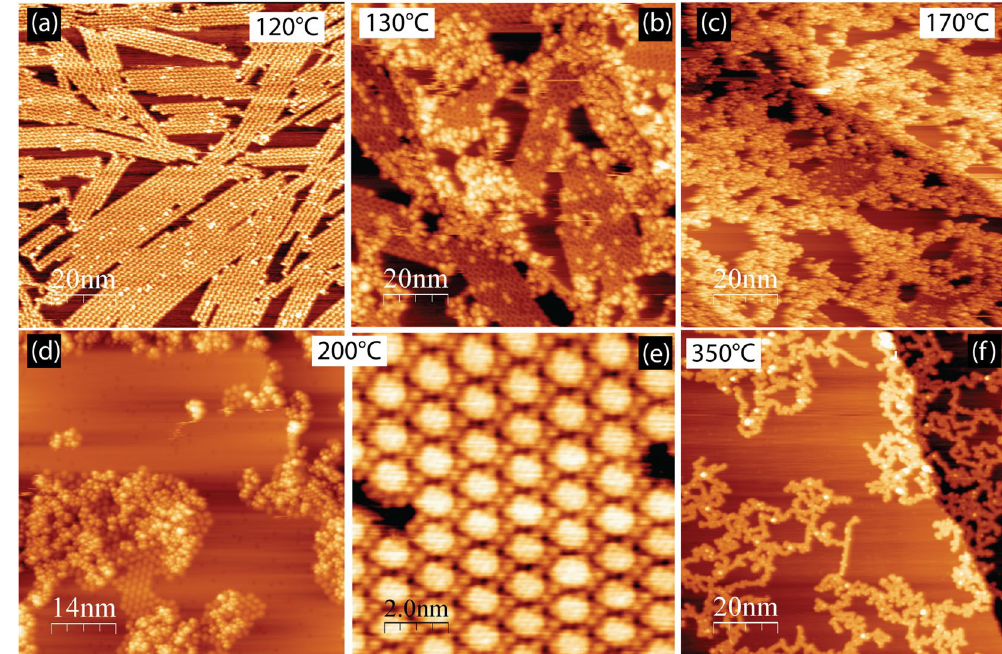
Figure 5. ( a – f ) STM images obtained after annealing DBBA on Ag(111) at indicated temperatures during the experiment when C-Ag-C bonds were not able to convert into the covalent ones. ( e ) The high-resolution image of the hexagonal island of nanographenes (square units) coordinated by Br adatoms (small round features in- between nanographenes. Tunneling parameters (V S /I T ): ( a ) − 1.7 V/200 pA; ( b ) + 1.5 V/200 pA; ( c ) + 1.5 V/200 pA; ( d ) + 1.5 V/100 pA; ( e ) − 0,04 V/230 pA; ( f ) − 1.5 V/200